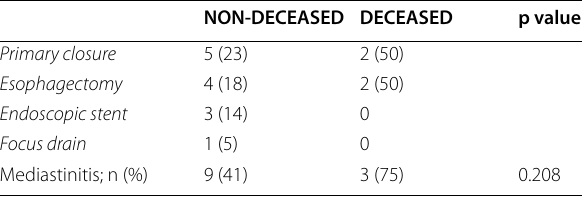
Table 1. Patients characteristics. Conclusion. In our cohort, the type of treatment received did not influence global mortality in patients with esophageal perforation, just as described in the literature. The need for respiratory support, amines and higher lactate values at admission were associated with higher